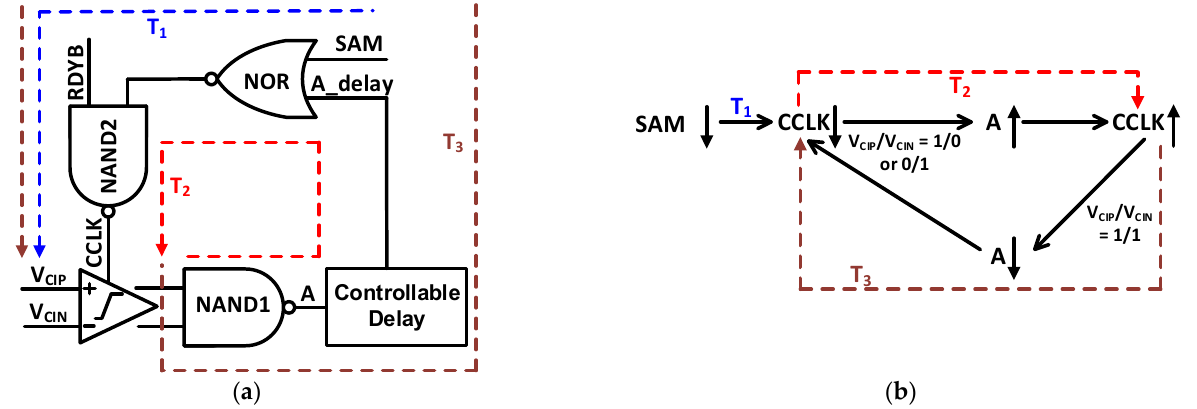
Figure 11. Asynchronous CCLK generator ( a ) Schematic of asynchronous clock generator with controllable delay ( b ) Logic description of CCLK generation.